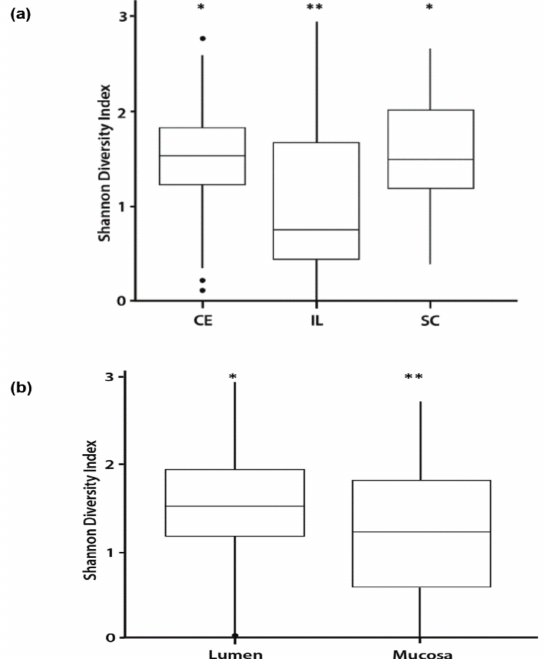
Figure 2. DNA was extracted from the lumen and mucosa of three intestinal tissues: Cecum (CE), ileum (IL), and spiral colon (SC) of calves and 16S sequencing was performed on the Illumina MiSeq Sequencer employing the Schloss MiSeq Wetlab protocol. All microbial community data analysis was performed using R version 3.6.1. Shannon diversity indices of microbial communities were calculated for each sample, within each tissue, using the package ‘vegan’, version 2.4-5. Shannon diversity indices for cecum, ileum, and spiral colon collapsed across treatments are presented, with greater values indicating increasing diversity within the tissue ( a ). Di ff erent superscripts are statistically di ff erent, *,** p < 0.001. Shannon diversity indices of microbial communities by either lumen contents or mucosa of all three major intestinal tissues; cecum, ileum, and spiral colon of calves are presented ( b ). Di ff erent superscripts are statistically di ff erent, *,** p <